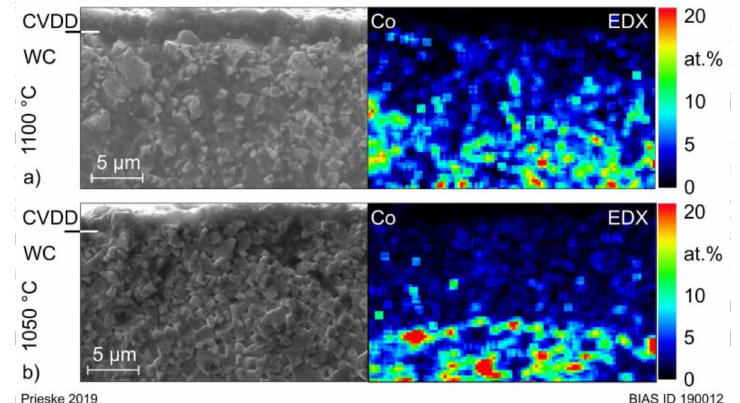
Figure 7. Secondary electrons images left and EDX mappings right, which show the percentage distribution of cobalt in cryofractures after the deposition at the process temperatures of 1100 ( a ) and 1050 ◦ C ( b